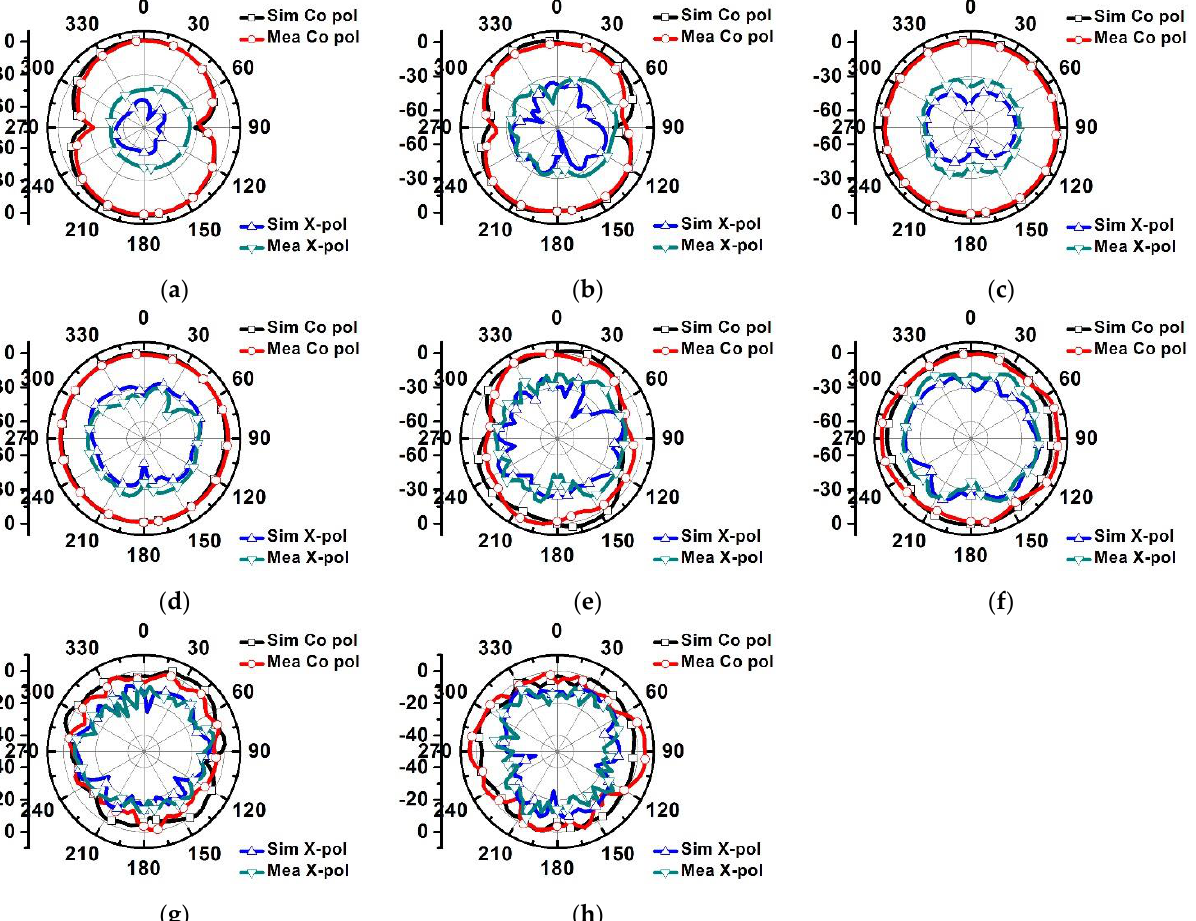
Figure 24. Far-field patterns of the sensing antenna in orthogonal planes at ( a ) 2.5 GHz (XZ), ( b ) 2.5 GHz (YZ), ( c ) 5 GHz (XZ), ( d ) 5 GHz (YZ), ( e ) 7.5 GHz (XZ), ( f ) 7.5 GHz (YZ), ( g ) 10 GHz (XZ), ( h ) 10 GHz (YZ).